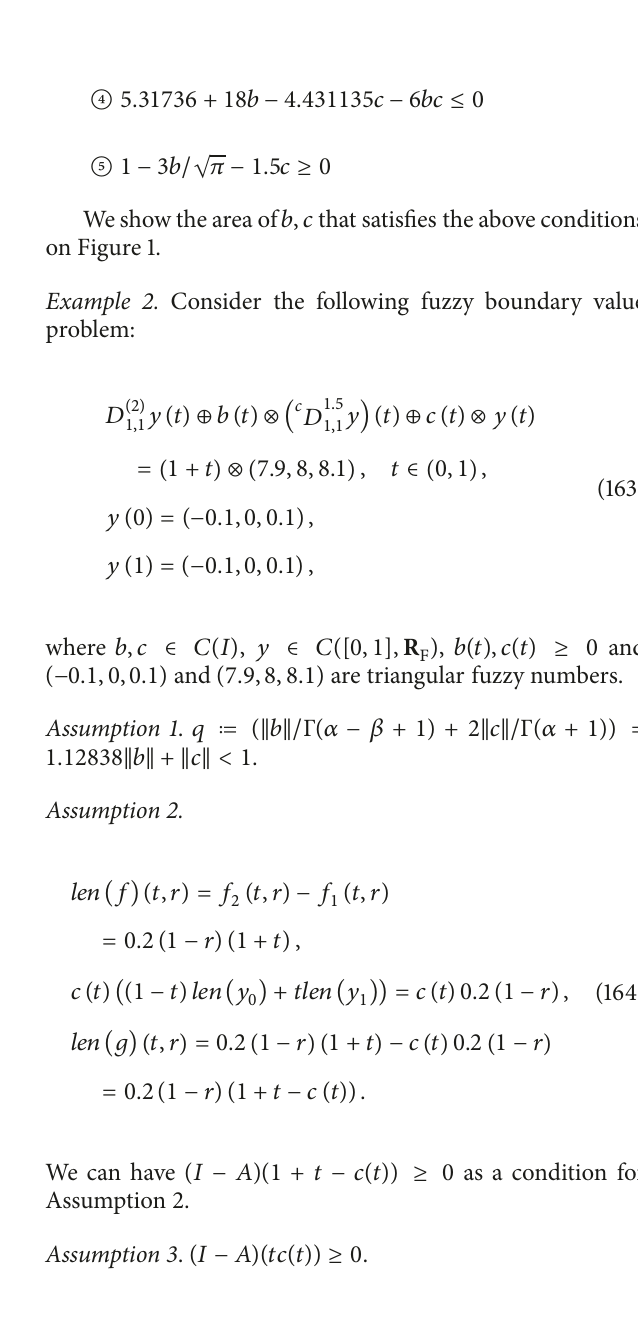
Figure 1: Area of 𝑏 and 𝑐 satisfying A - E for Example